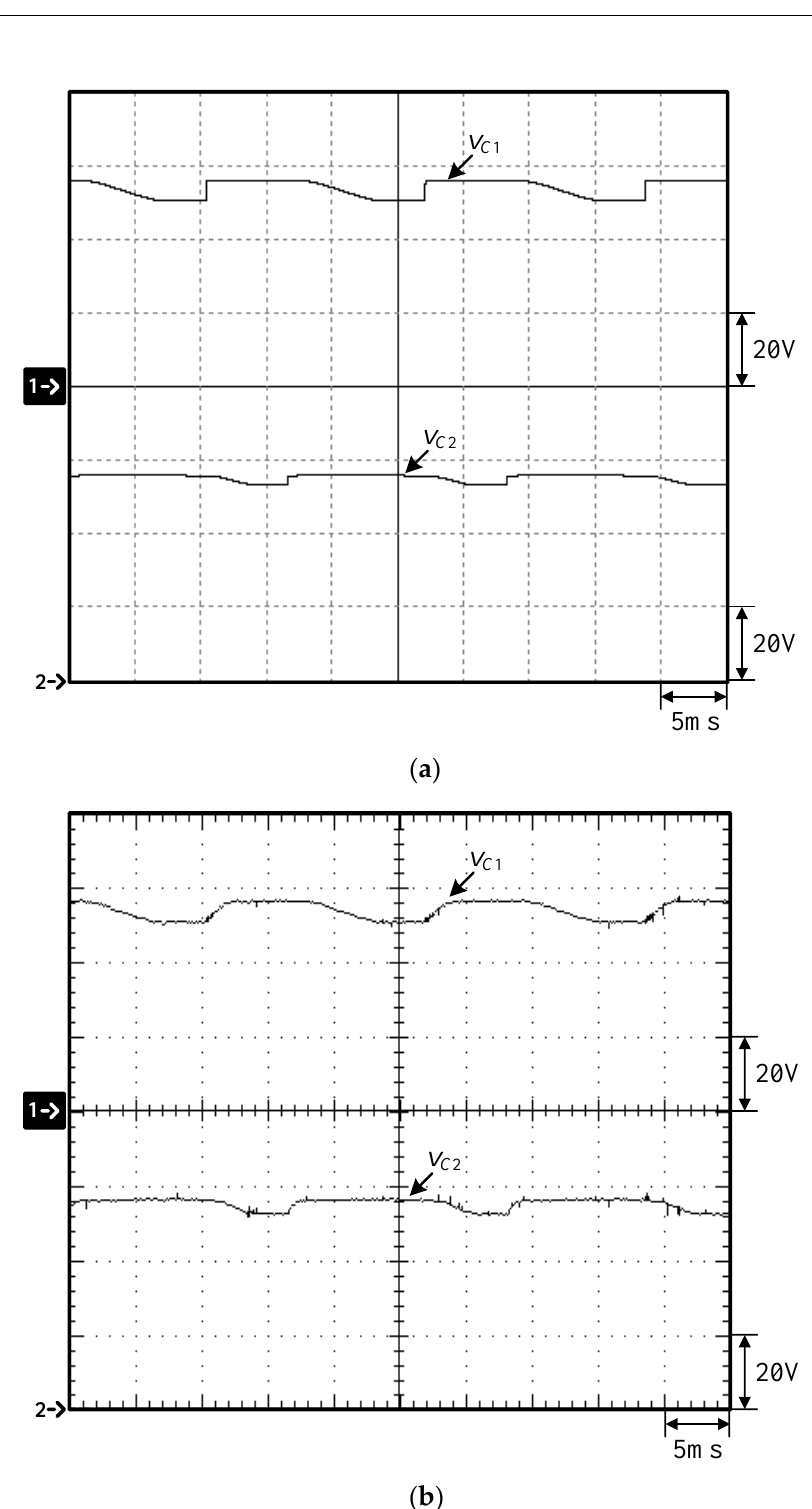
Figure 17. Waveforms at rated load with (1) v C 1 and (2) v C 2 : ( a ) simulated; ( b ) measured.